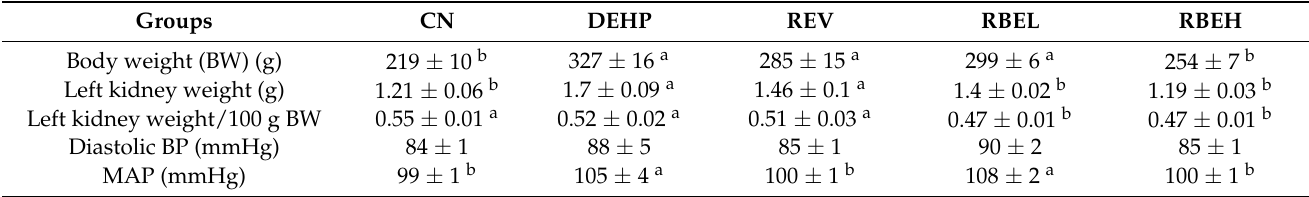
Table 2. Weights and blood pressures of male offspring at 12 weeks of age.